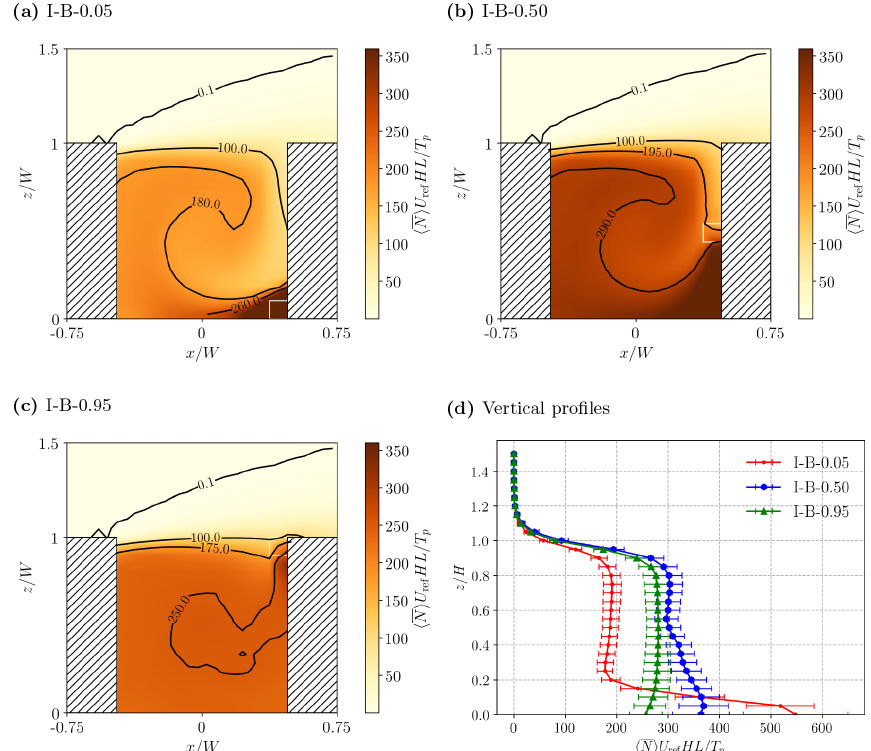
Figure 8. As in Fig. 6 but for isolated kitchens and boiling. The kitchens are located at (a) z/H = 0 . 05, (b) z/H = 0 . 5 and (c) z/H = 0 . 95. Mean vertical profiles are plotted in panel (d)